Question: What form of chart is displayed?
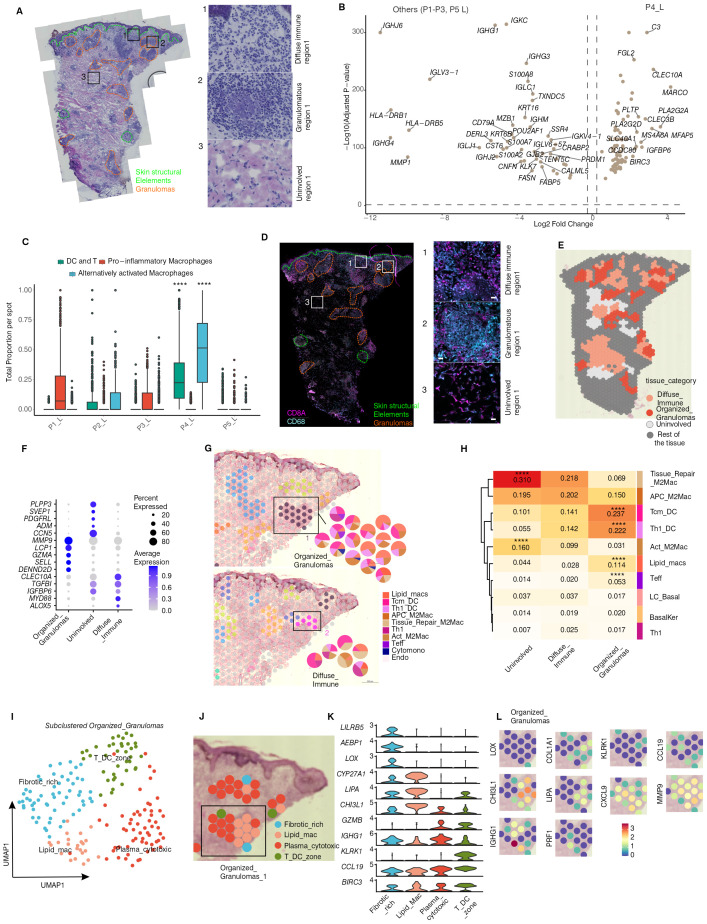
Answer: scatter